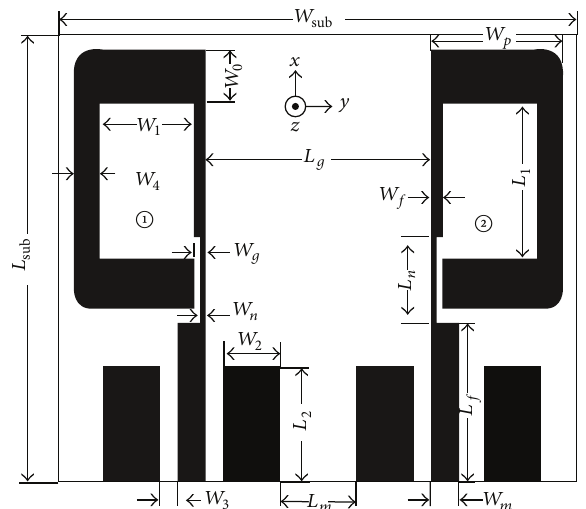
Figure 1: Proposed antenna configuration.